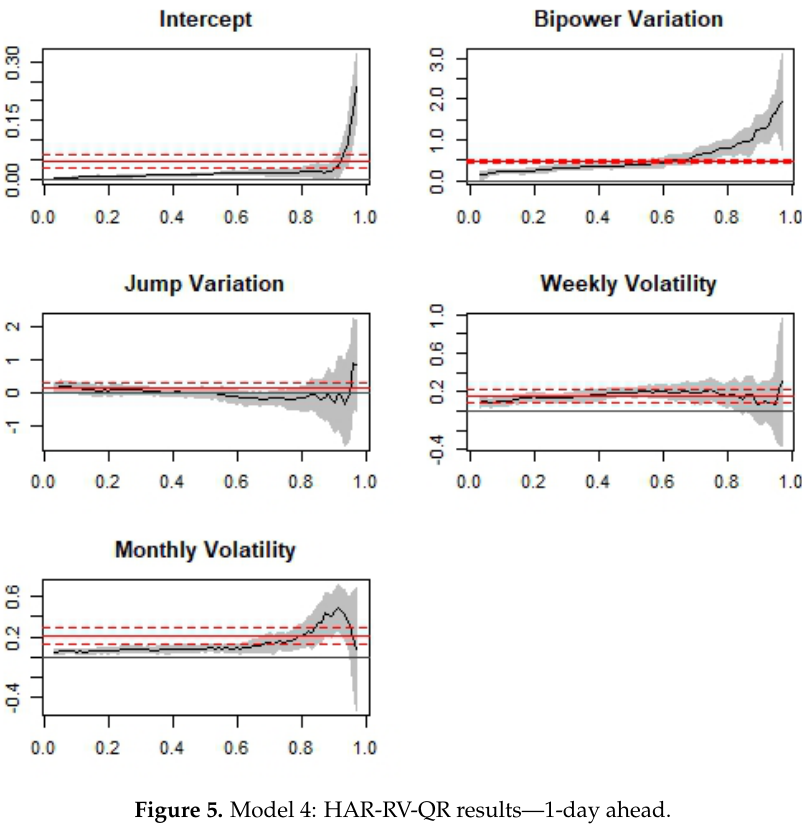
Figure 5. Model 4: HAR-RV-QR results—1-day ahead.